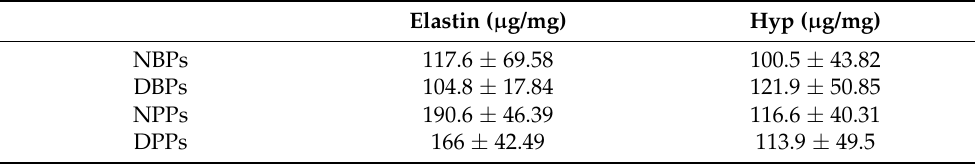
Table 2. Elastin and hydroxyproline quantification in native and decellularized bovine (NBPs and DBPs) and porcine (NPPs and DPPs) pericardia. Data are expressed as mean ± SD.